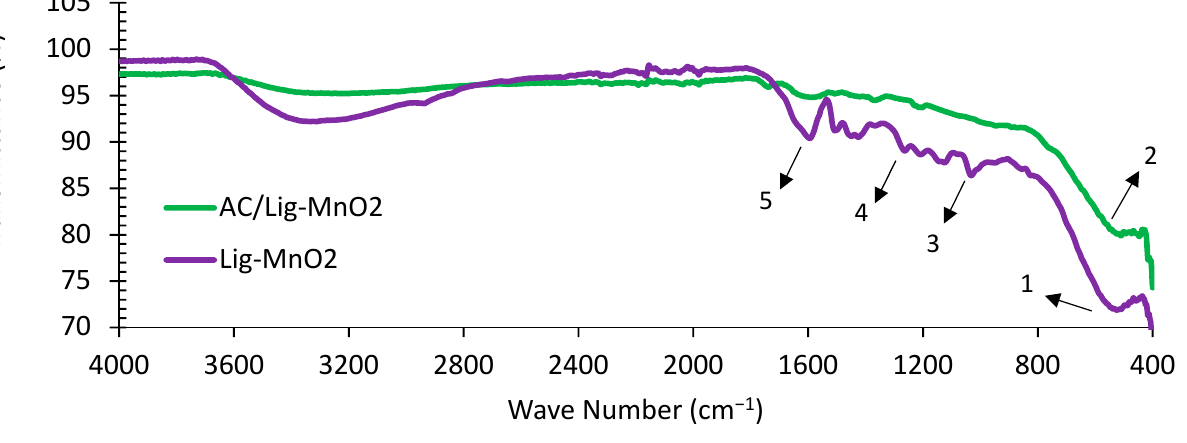
Figure 3. FTIR spectroscopy of AC/Lig-MnO 2 and Lig-MnO 2.